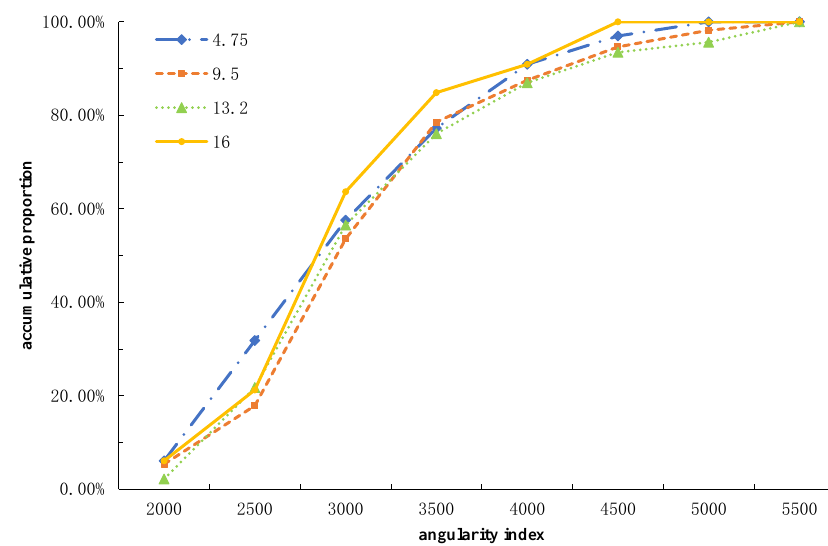
Figure 7. Angularity index distribution of different sizes of particles.